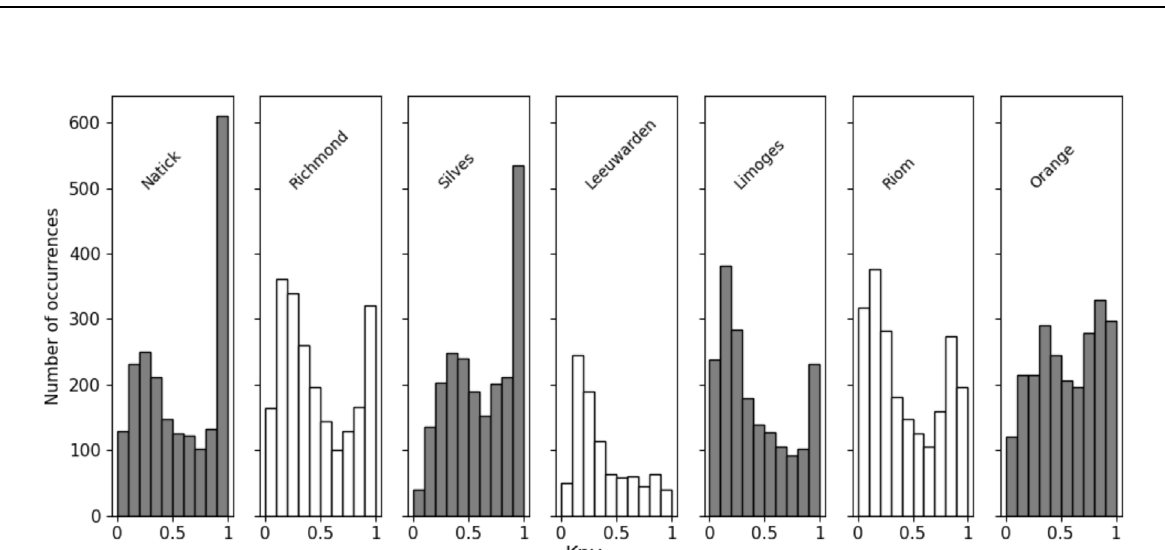
Fig. 2. Clear sky index distribution for the 7 considered PV plants during the 6 months of the